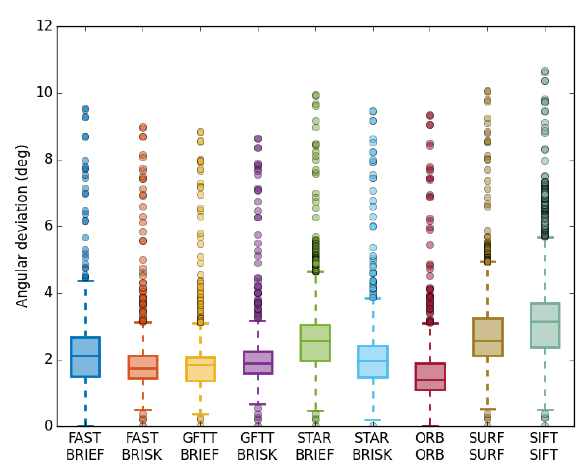
Figure 7. Absolute orientation